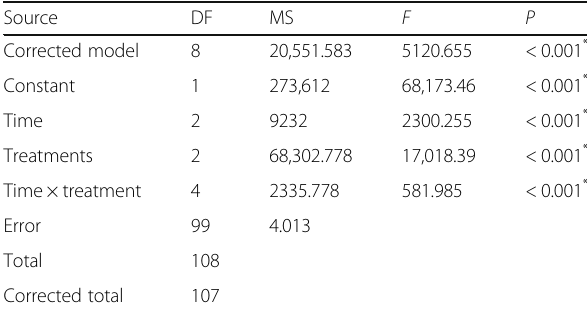
Table 1 Analysis of variance comparison of mortality rate of 1 st instar larvae of Helicoverpa armigera bioassayed with bacterial isolate Hr1